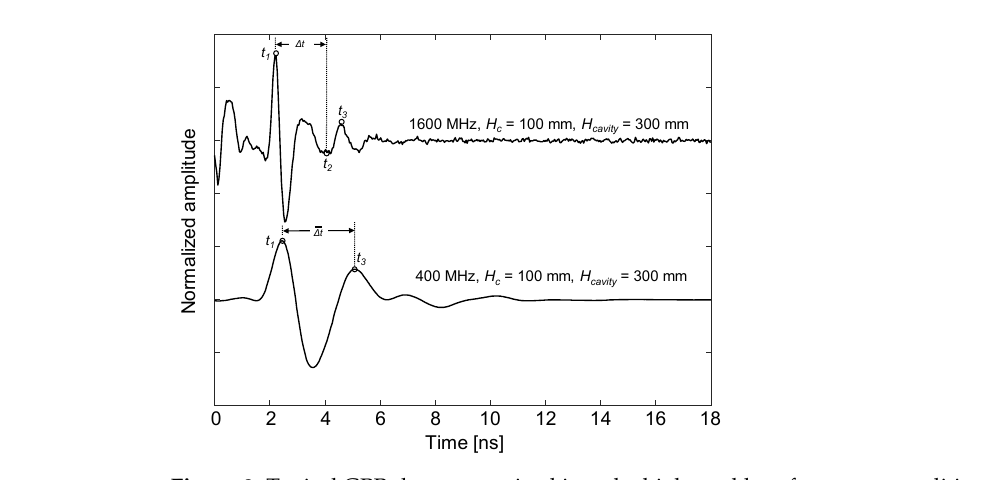
Figure 8. Typical GPR data categorized into the high- and low-frequency conditions. The upper and lower signals were measured over the 300 mm thick air-cavity behind the 100 mm thick concrete by 1600 MHz and 400 MHz antennas, respectively.